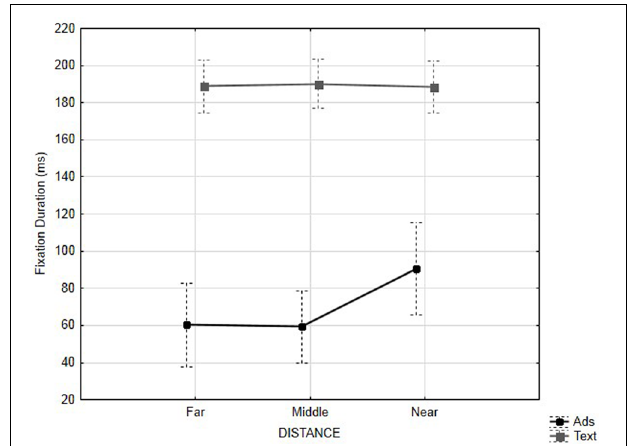
FIGURE 4 | Average fixation duration (ms) according to distance and zone (AOIs).